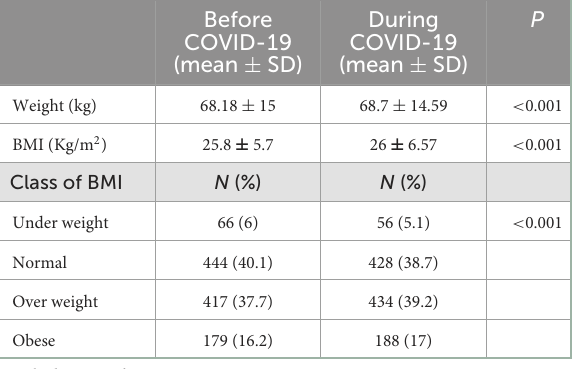
TABLE 2 Weight status of participants before and during COVID. Before